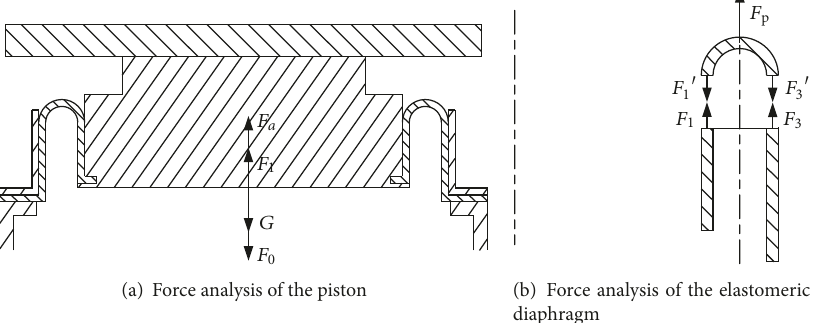
Figure 3: Force analysis of the piston and elastomeric diaphragm.